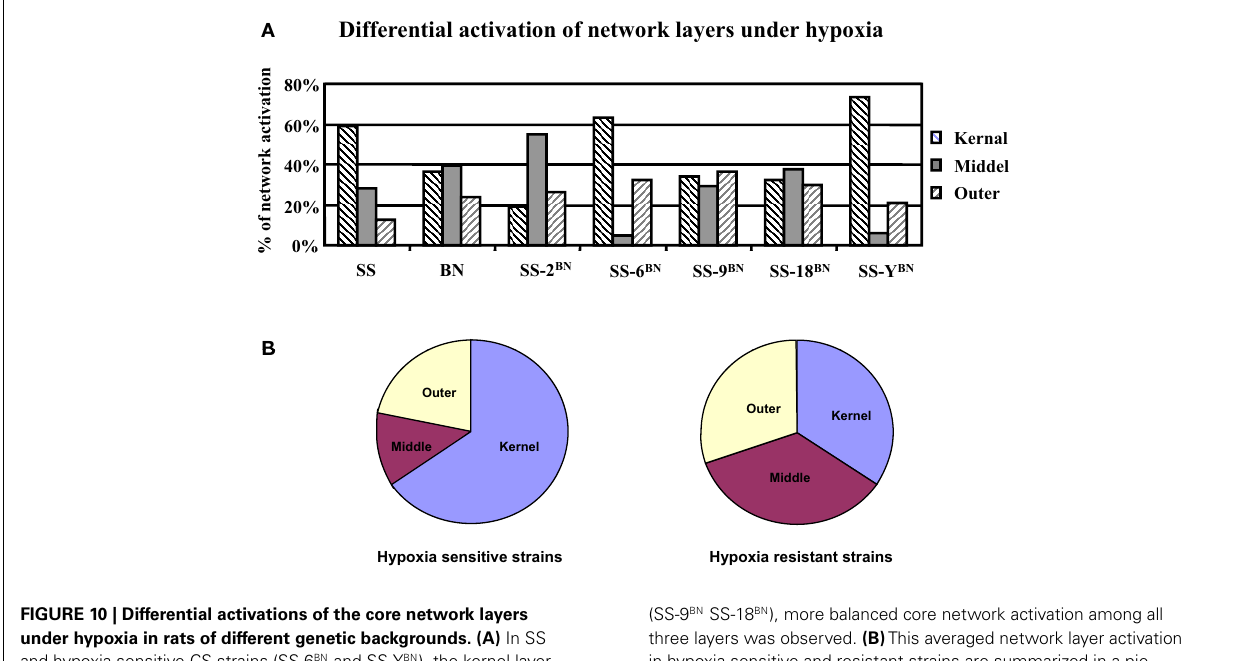
FIGURE 10 | Differential activations of the core network layers under hypoxia in rats of different genetic backgrounds. (A) In SS and hypoxia sensitive CS strains (SS-6 BN and SS-Y BN ), the kernel layer was predominantly activated. In BN and hypoxia-resistant strains